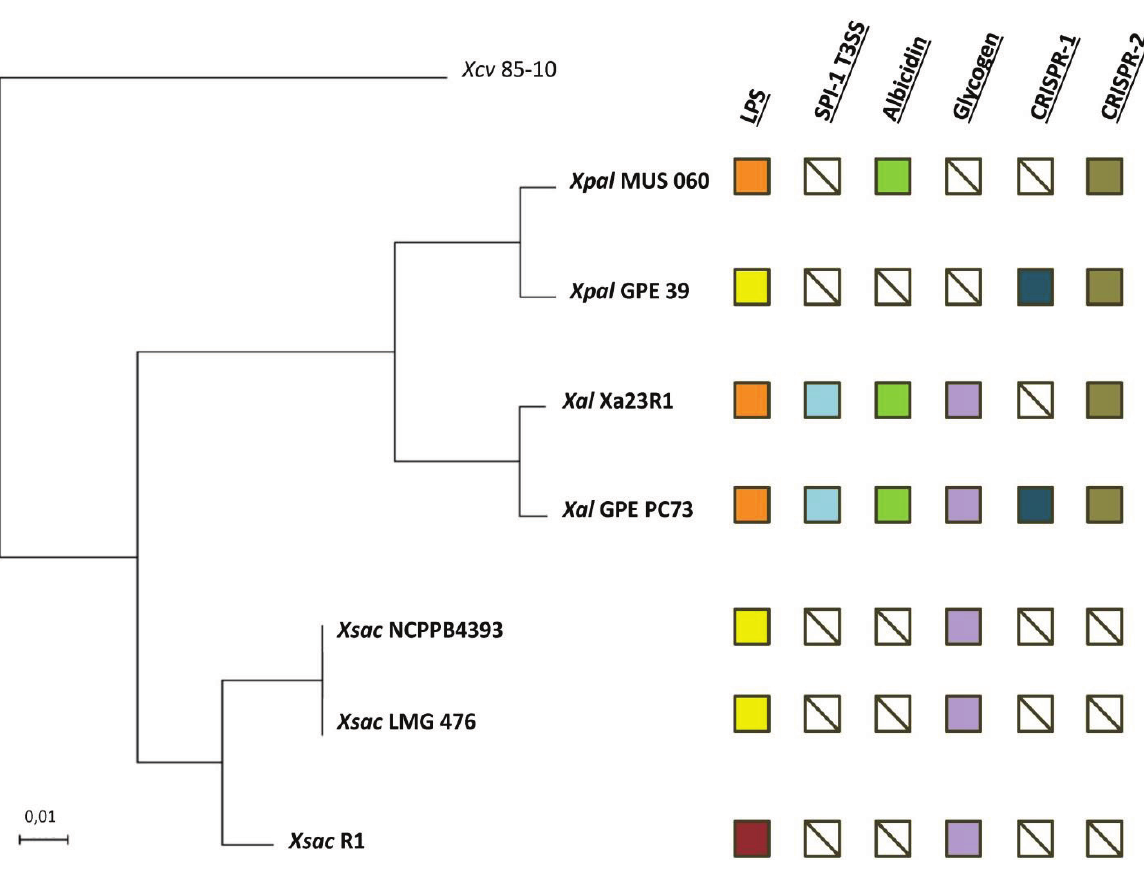
Figure 1. Phylogenetic relationship and overview of some variable genomic regions between strains of Xanthomonas albilineans ( Xal ), “ Xanthomonas pseudalbilineans ” ( Xpal ) and Xanthomonas sacchari ( Xsac ). Multi-locus sequence analysis (MLSA) tree based on seven concatenated housekeeping gene sequences generated using the maximum likelihood method. Xanthomonas axonopodis pv. vesicatoria strain 85-10 ( Xcv ) was used as outgroup. All branches were supported by bootstrap values of 100% after 500 replicates. The scale bar indicates the fraction of substitution per site. Orange and yellow squares indicate the presence of lipopolysaccharide (LPS) loci LPS1 or LPS3, respectively. The dark red square corresponds to the LPS locus of strain R1 of X. sacchari , which does not share any gene with loci LPS1 or LPS3. Other squares indicate the absence (crossed white) or presence of type 3 secretion system of the Salmonella pathogenicity island-1 family (SPI-1 T3SS; blue), albicidin (green), glycogen (violet) and clustered regularly interspaced short palindromic repeats (CRISPRs) (dark blue or brown)